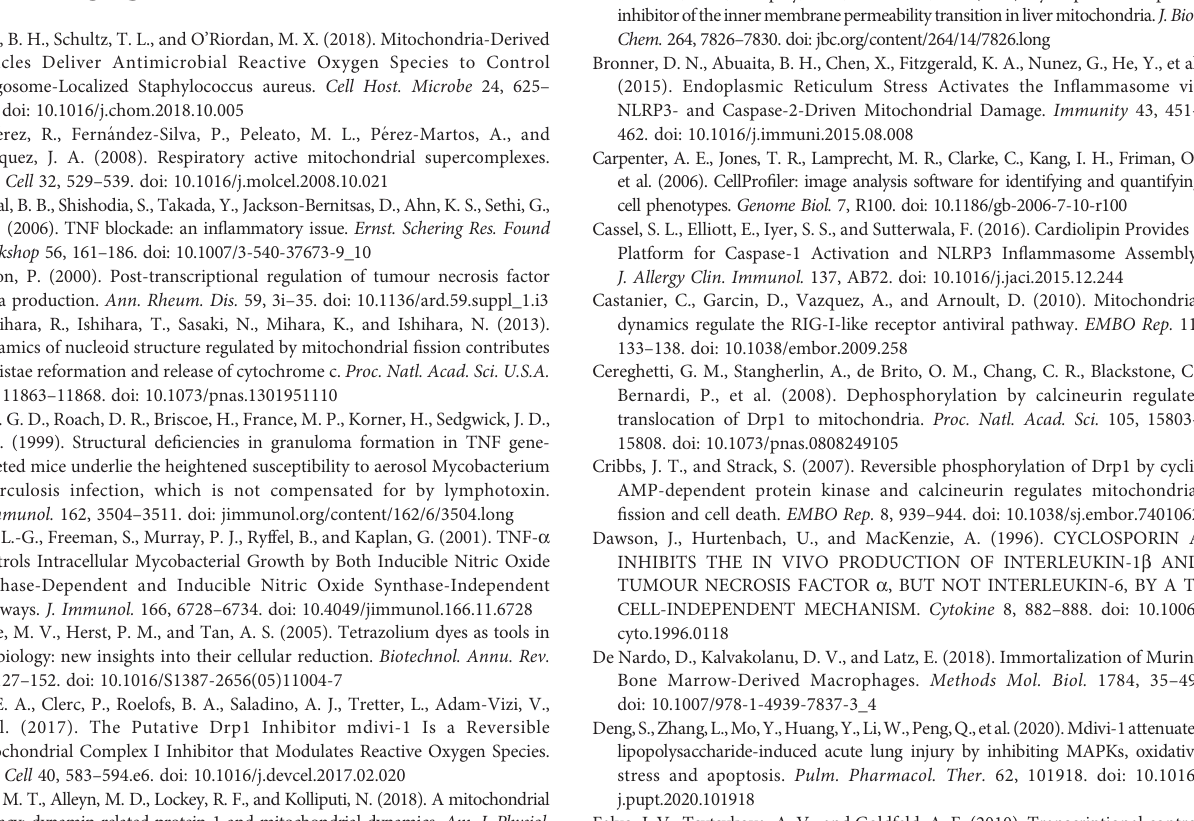
circularity. MitochondriaI objects with area less than 1 µm 2 and a circularity greater than 0.6 were considered fragmented for the purpose of quanti fi cation. Cell-level ANOVA with Sidak ’ s post-test for multiple comparisons. ** P < 0.01; *** P < 0.001; **** P < 0.0001. SUPPLEMENTARY FIGURE 3 | Silencing DRP1 reduces cellular redox. NT- Control and DRP1 KD macrophages were left untreated (Mock) or stimulated with LPS (200 ng/ml) and cellular redox was assessed by using Resazurin (A) and WST- 1 (B) substrates. Graphs indicate mean ± SD of n ≥ 3 independent experiments. Two-way ANOVA with Sidak ’ s multiple comparisons post-test was performed to calculate P values. ** P < 0.01; **** P < 0.0001. SUPPLEMENTARY FIGURE 4 | DRP1 knockdown does not affect LPS or MRSA-induced Il1 b transcription in macrophages. DRP1 KD and NT-Control macrophages were stimulated for 4 h +/- LPS (200 ng/ml) or MRSA (MOI 20) and then the levels of Il1 b transcript were analyzed by RT-qPCR. Data were normalized against NT-Control macrophage untreated (Mock) condition.Graphs indicate mean ± SD of n ≥ 3 independent experiments. Two-way ANOVA with Sidak ’ s multiple comparisons post-test was performed to calculate P values. * P <